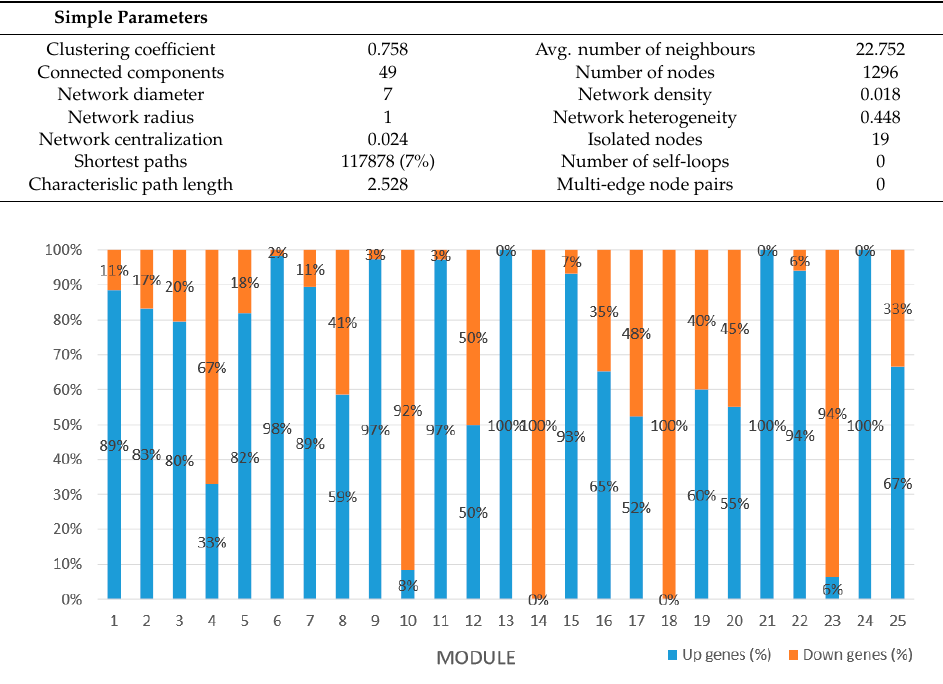
Figure 12. Expression trends of genes in modules.